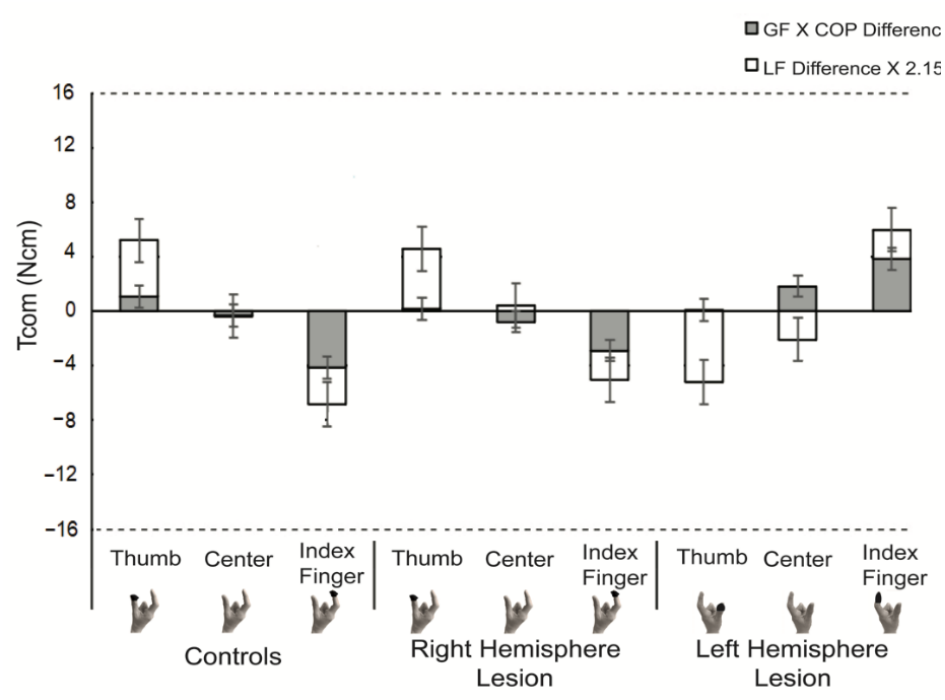
Figure 4. Stacked bar graph of Tcom components. Tcom = compensatory torque; LF = load force; GF = grip force; COP = center of pressure. The dotted horizontal line represents target Tcom. The black circle on the picture of the hand below the graph represents which digit was on the side the heavy COM was located.